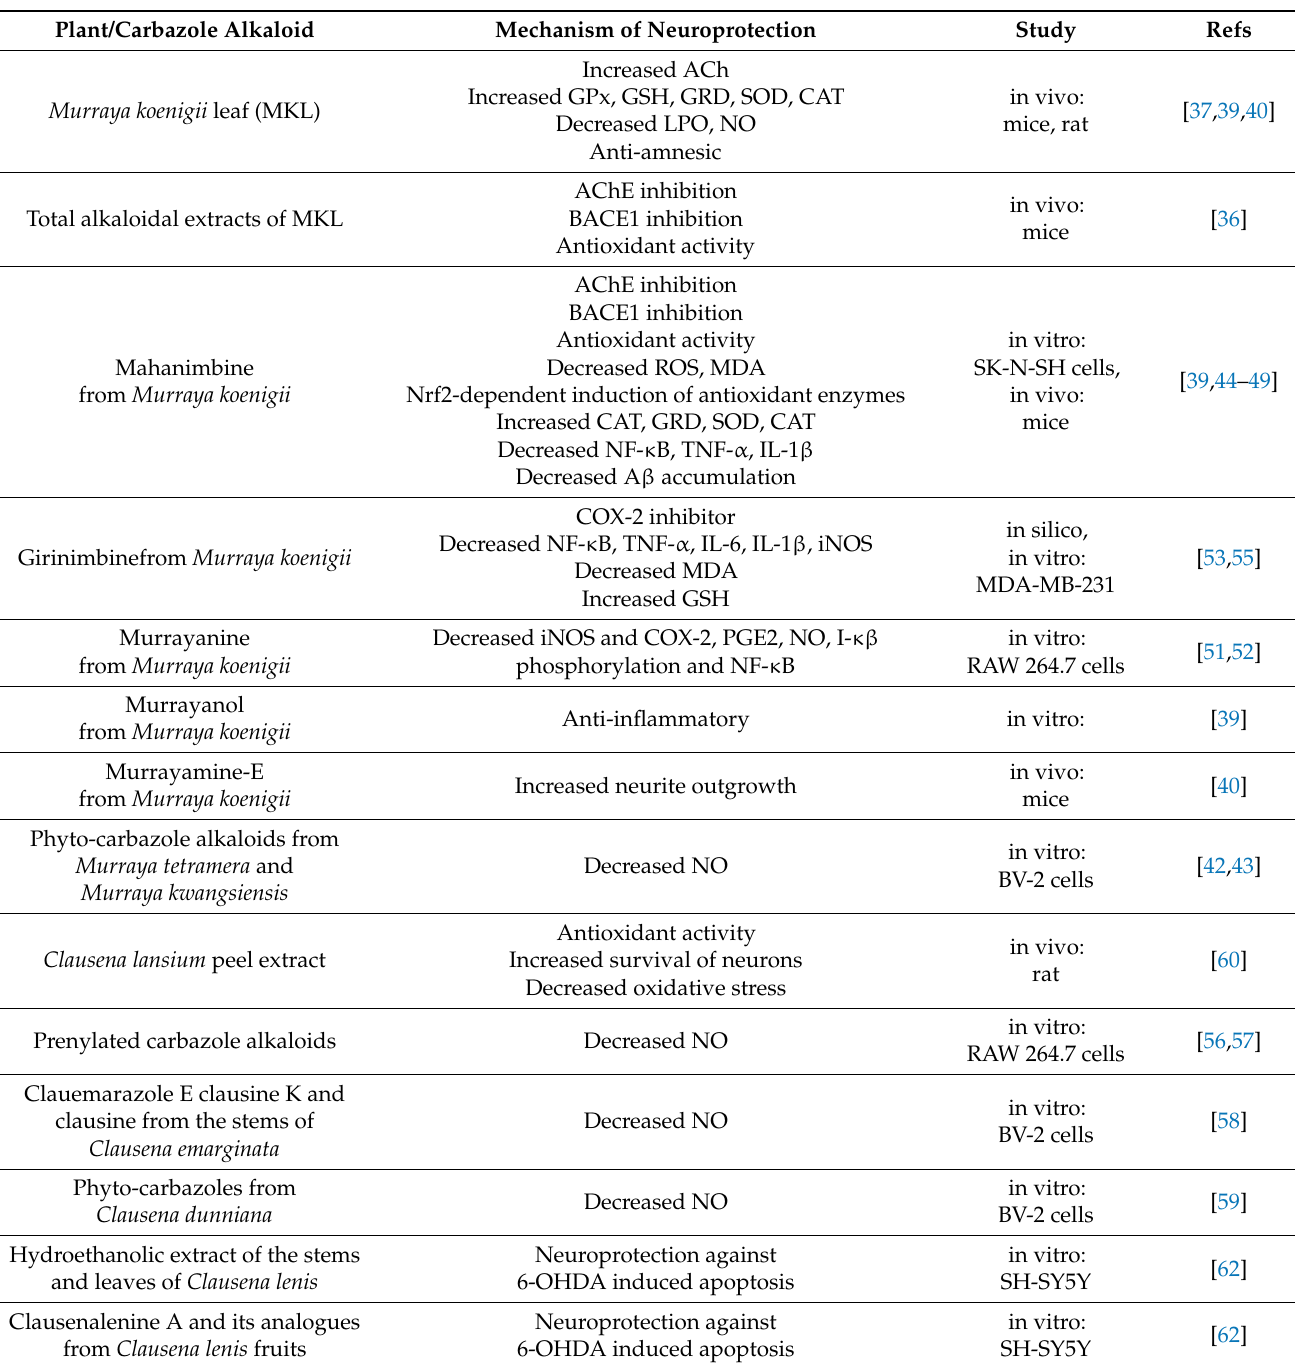
Table 1. Neuroprotective mechanism displayed by Rutaceae family plant extracts and phyto- carbazole